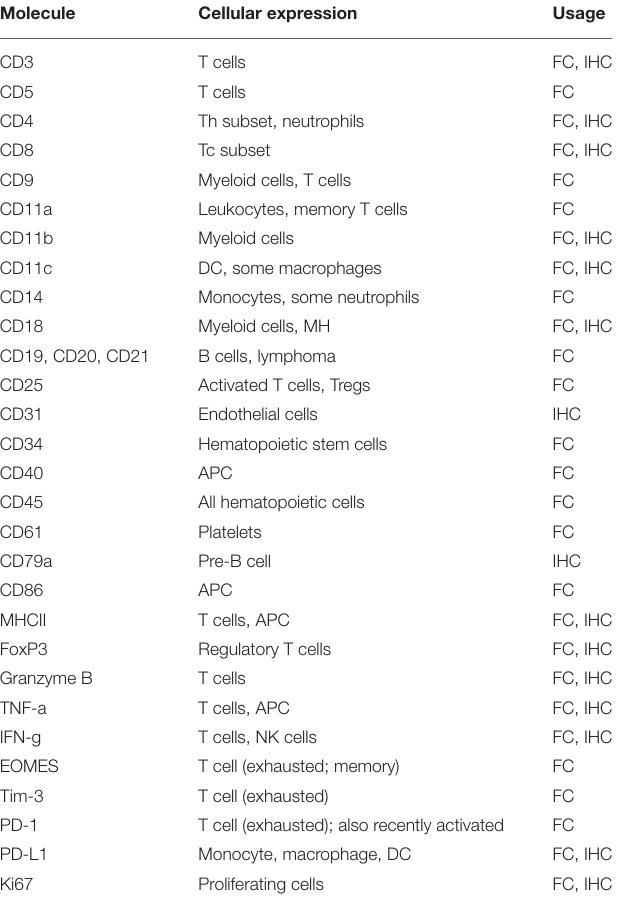
TABLE 2 | Immunological reagents for cell identification and functional assessment in dogs with cancer. Molecule Cellular